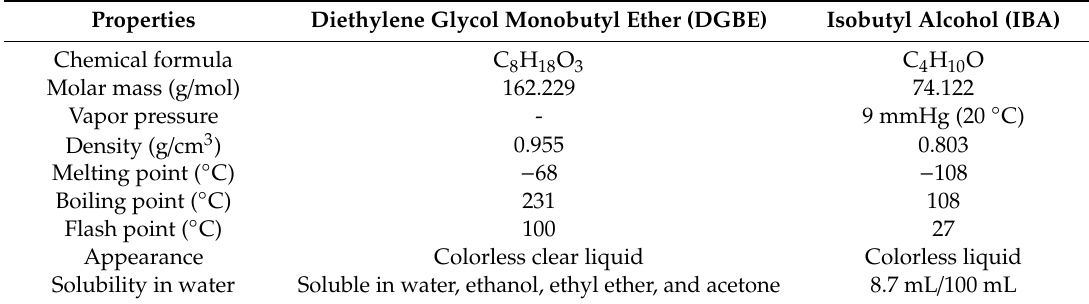
Table 3. Components of crude oil sampled at the target reservoir planned to conduct ASP